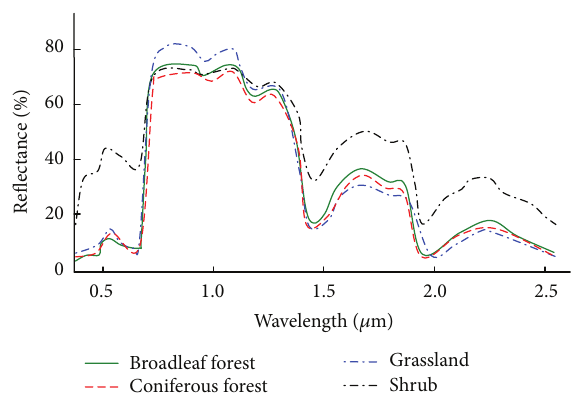
Figure 2: The spectral curves of different tree species.